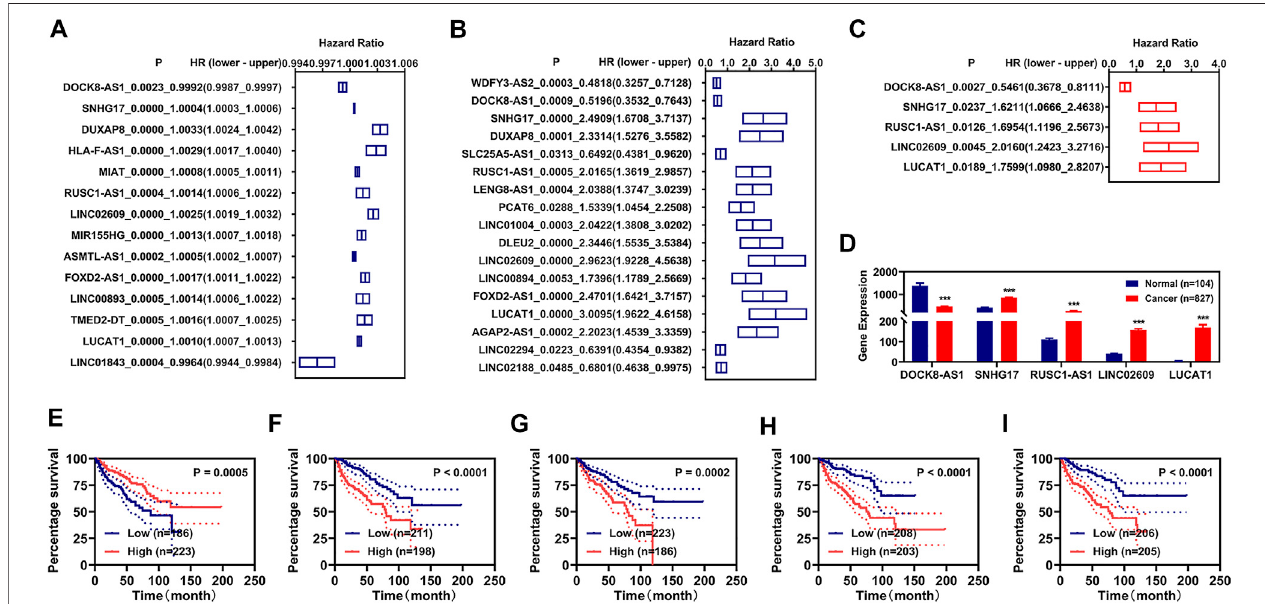
FIGURE 1 | Identi fi cation of FR-DELs as prognosis signatures. (A, B) , Univariate Cox regression and K-M analyses illustrate that 14 FR-DELs (A) and 17 FR-DELs (B) were associated with OS in the training group, respectively. (C) Multivariate Cox regression illustrates that 5 FR-DELs were independently associated with OS in the traininggroup. (D) Theexpressionofthose5FR-DELsinnormalgroupandcancergroup. (E – I) Kaplan – Meiercurvesofthose5FR-DELs(DOCK8-AS1 (E) ,SNHG17 (F) , RUSC1-AS1 (G) , LINC02609 (H) , and LUCAT1 (I) ) in renal cancers. * p < 0.05, ** p < 0.01, *** p < 0.001. FR-DELs, ferroptosis-related differentially expressed lncRNAs; K-M, Kaplan – Meier; OS, overall survival.